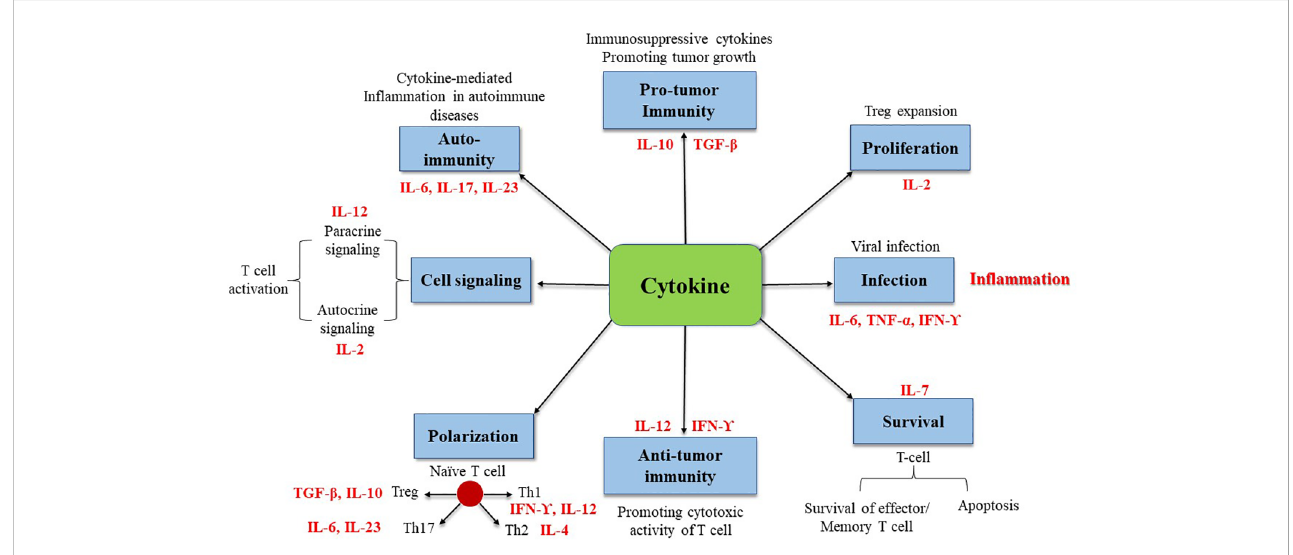
FIGURE 1 Illustration of cytokines involved in immune